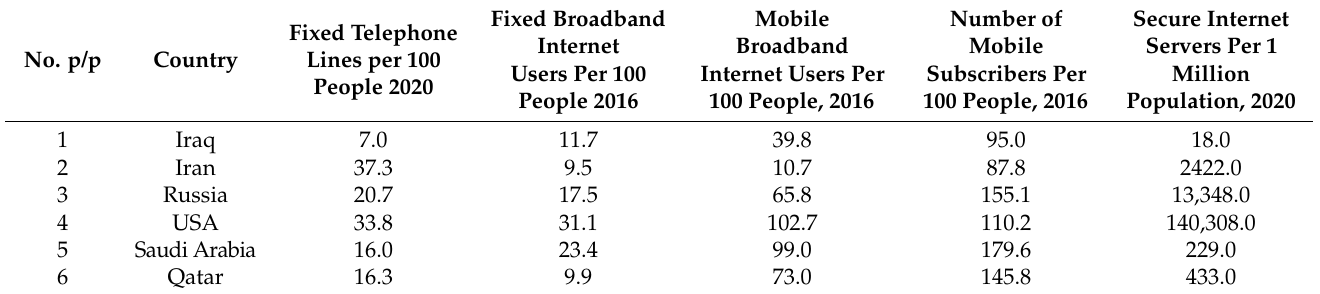
Table 7. Indicators characterizing the information infrastructure by